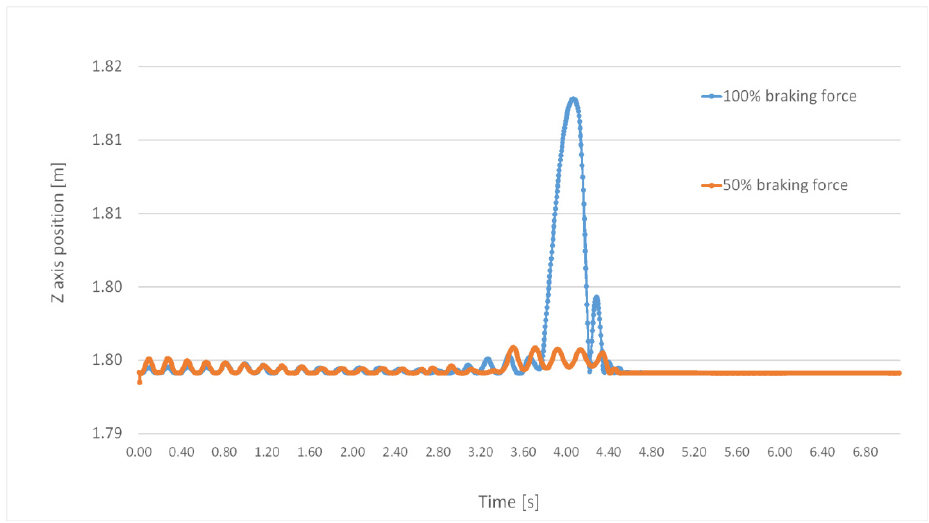
Figure 14. Displacement of the rail No. 5 along the Z axis, during braking from speed 5 m/s. Displacement of rails changes the traverse position in suspensions, which leads to loosening of one suspension and excessive load to the other one of the pair of diagonal suspensions stabilizing the monorail route. The successive stages of changing the posi- tion of the traverse in the rail suspension and the way of loading the suspensions are shown in Figure 15.